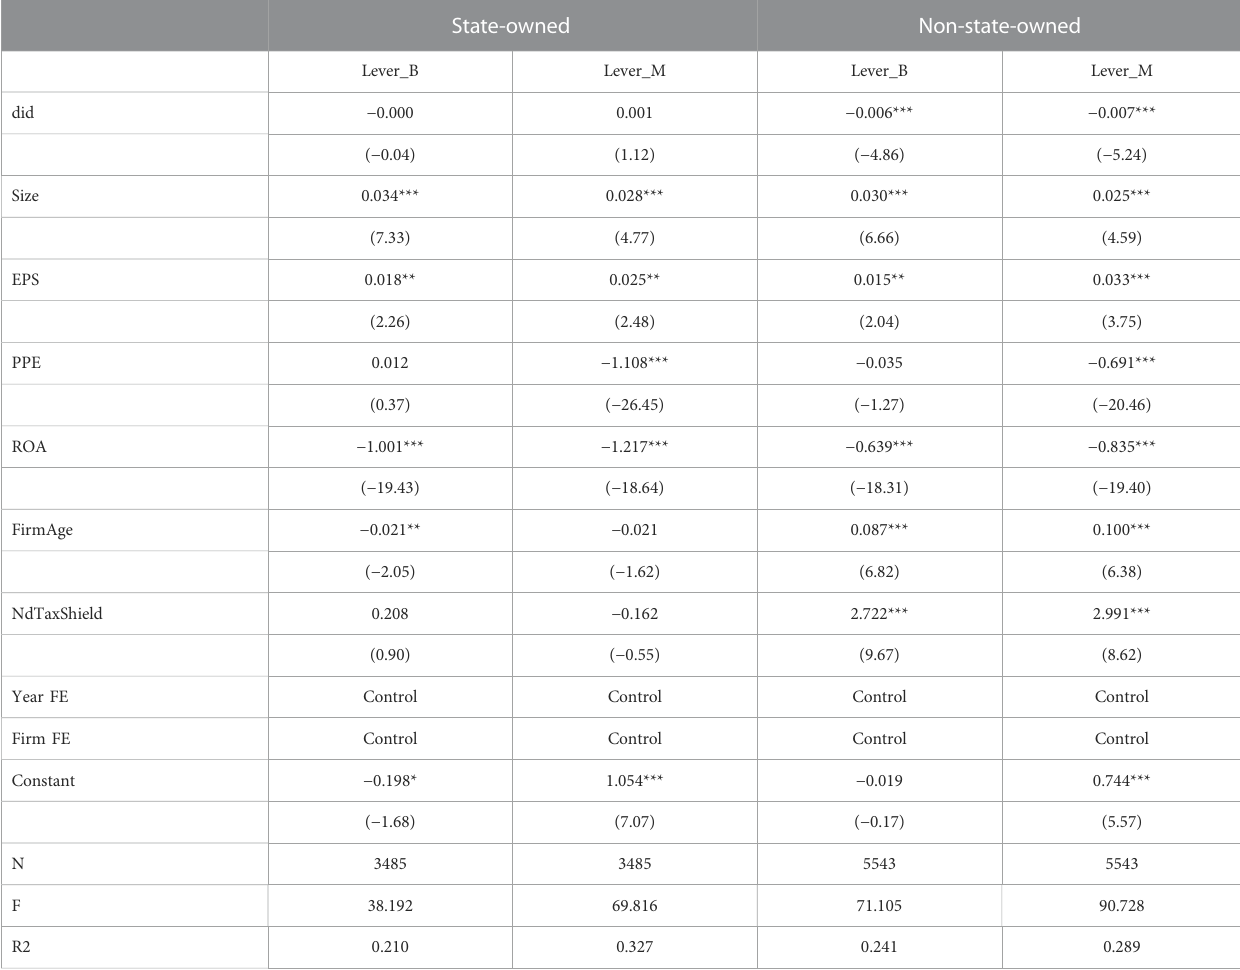
TABLE 10 Carbon trading and corporate capital structure under different corporate